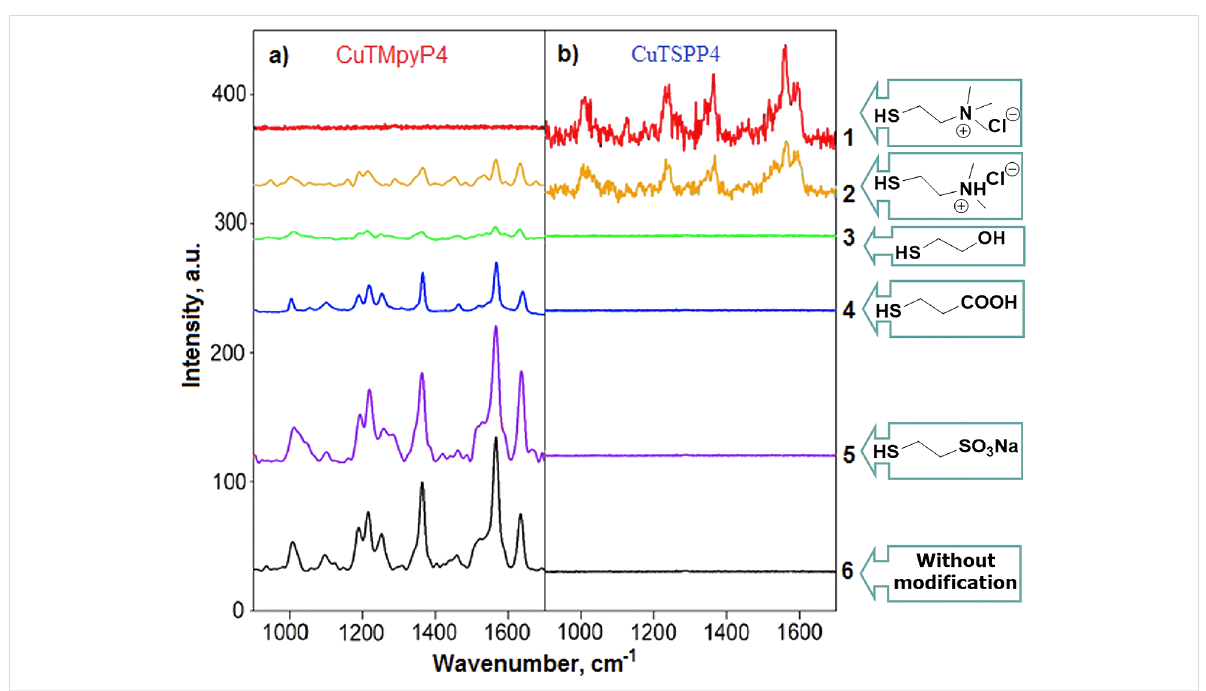
Figure 5: SERS spectra of (a) CuTMpyP4 and (b) CuTSPP4 drop-cast from 10 − 6 M solution onto the substrate modified with (1) thiocholine, (2) 2-(dimethylamino)ethanethiol hydrochloride, (3) 2-mercaptoethanol, (4) mercaptopropionic acid, (5) sodium mercaptoethyl sulfonate, and onto (6) the unmodified plasmonic